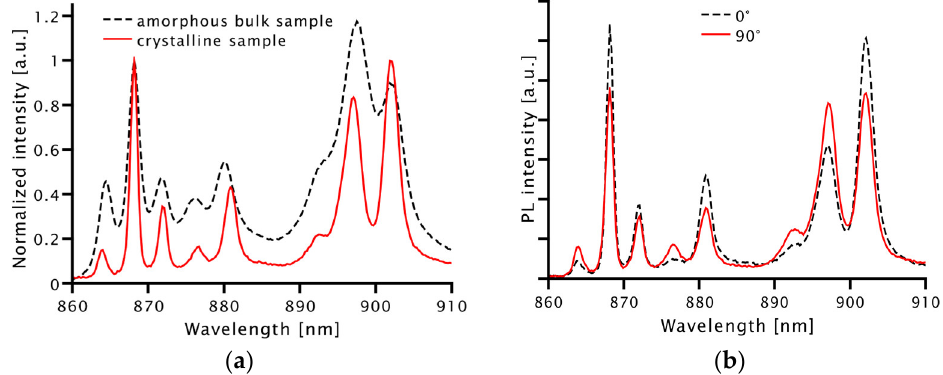
Figure 6. ( a ) The normalized PL emission spectra at 5 K of [Nd( L3 ) 2 (NO 3 ) 3 ] ( 5 ) corresponding to 4 F 3/2 → 4 I 9/2 transition from amorphous bulk sample (dashed line) and crystalline sample (solid line). ( b ) Low-temperature (5 K) PL spectra of crystalline [Nd( L3 ) 2 (NO 3 ) 3 ] ( 5 ) of the 4 F 3/2 → 4 I 9/2 transition taken at a polarization angle of 0° and 90°.